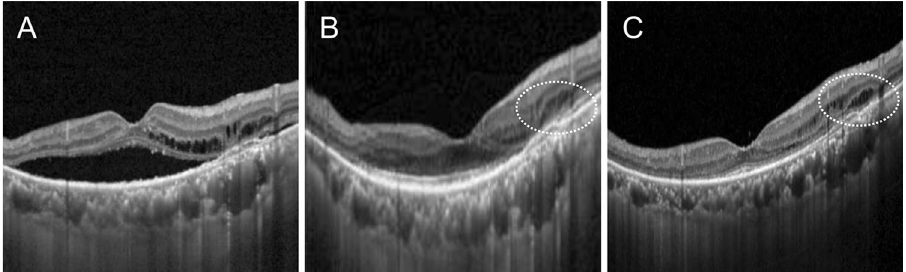
Figure 2. A representative case showing the difference in the prediction of post-treatment retinal fluid status between human retina specialists and artificial intelligence (AI) models. Before treatment, both subretinal fluid and intraretinal fluid (IRF) are noted on an optical coherence tomography image ( A ). Two human examiners predicted the complete resolution of retinal fluid after aflibercept treatment, whereas the AI model predicted the remaining IRF ( B , synthetic image, dotted circle). Residual IRF is noted (dotted circle) as per the AI model prediction on a real image obtained after aflibercept treatment ( C ).